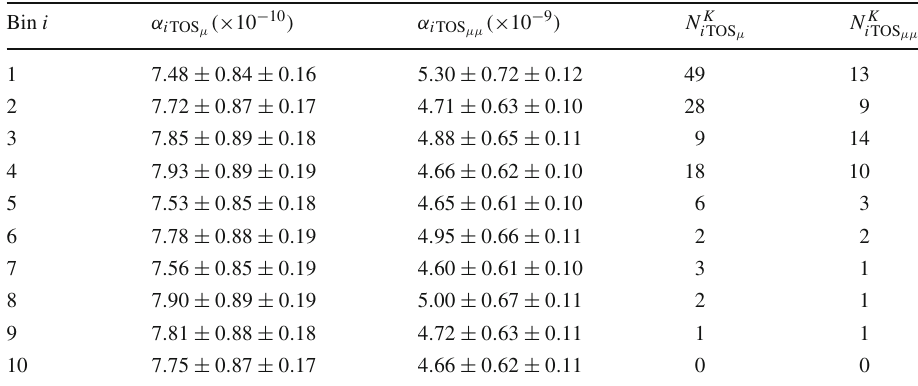
Table 1 Values of the single candidate sensitivity α ij and the number of candidates N K